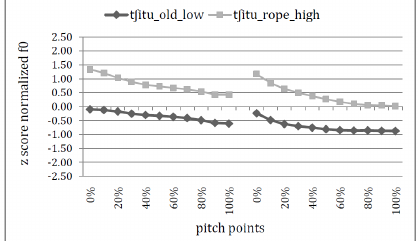
Figure 10: Normalized pitch contours for [tʃitu], (n=20{5 speakers*4 iterations each})